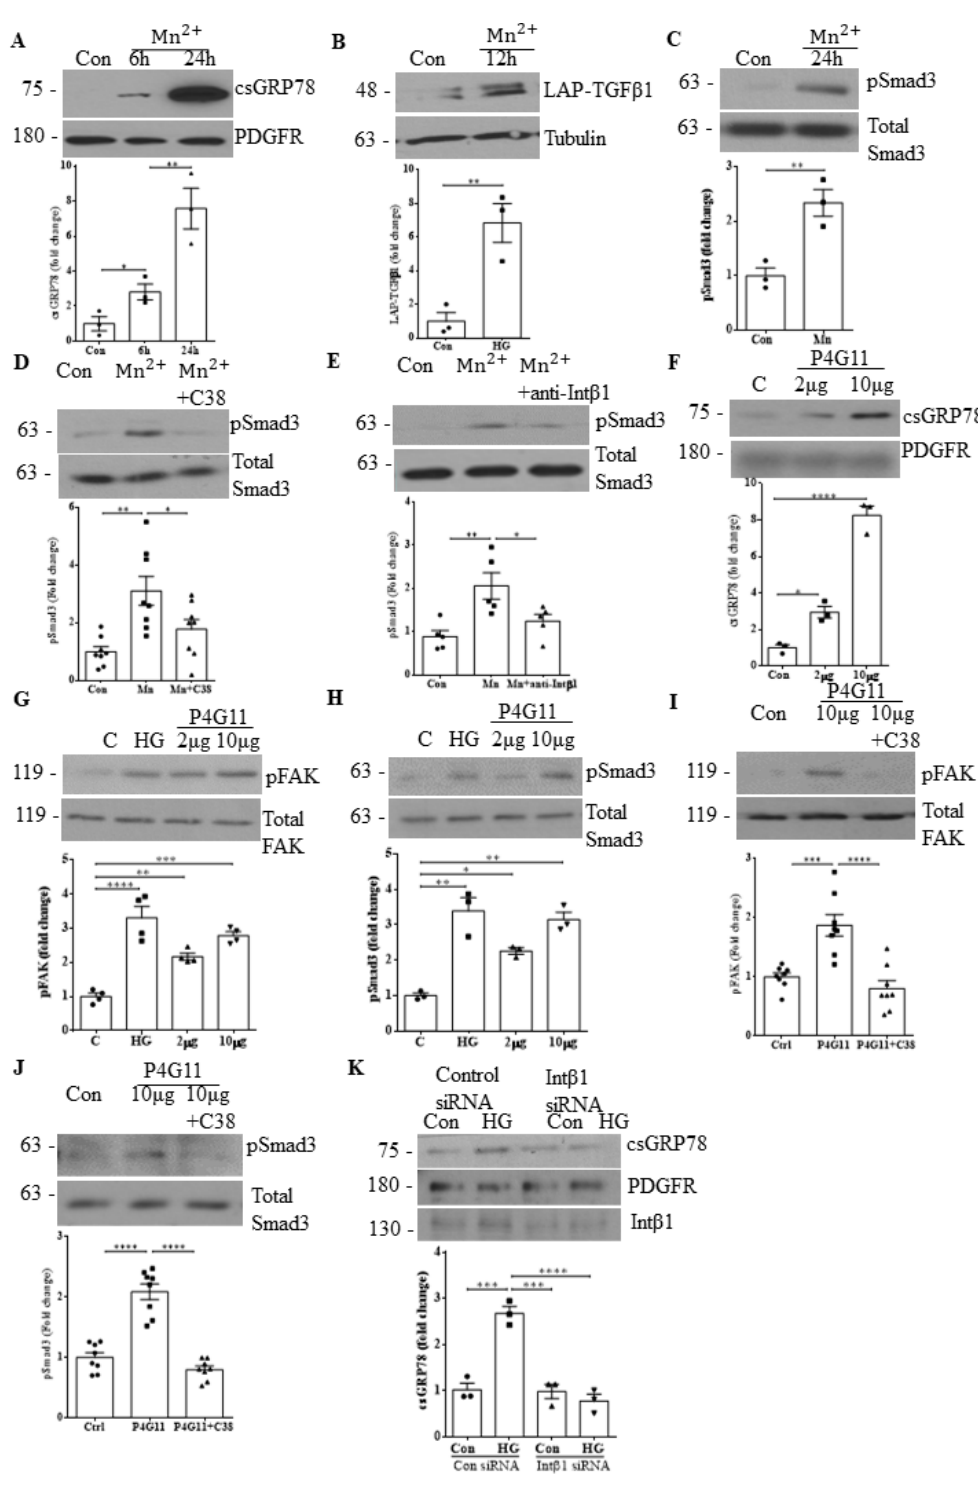
Figure 6 . Integrin β 1 contributes to GRP78 cell surface translocation. Activation of integrins using manganese. (Mn) induced ( A ) localization of GRP78 to the cell surface ( n = 3, * p < 0.05, ** p < 0.01), ( B ) production of LAP-TGF β 1 ( n = 3, ** p < 0.01) and ( C ) downstream TGF β 1 signaling measured as Smad3 phosphorylation (Ser473/475) ( n = 3, ** p < 0.01). Inhibition of either ( D ) csGRP78 using the C38 antibody ( n = 8, * p < 0.05, ** p < 0.01) or ( E ) integrin β 1 using a neutralizing antibody ( n = 5, * p < 0.05, ** p < 0.01) attenuated Mn (24 h)-induced activation of Smad3 (phosphorylation at Ser473/475). To specifically assess the role of integrin β 1, its activating antibody P4G11 was used.